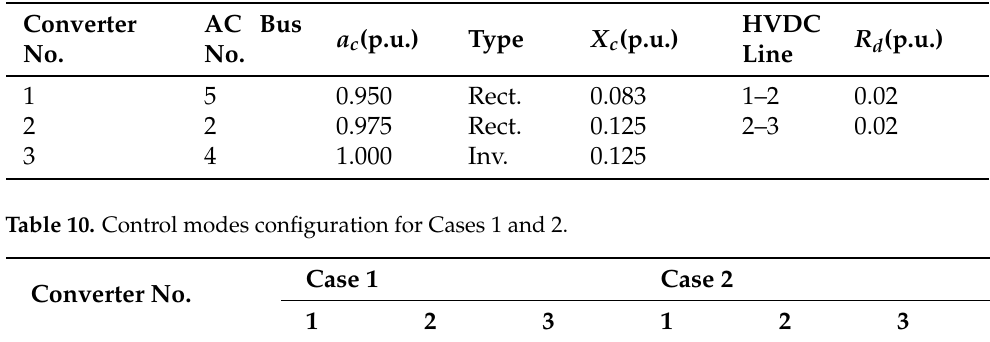
Table 9. The HVDC system configuration.